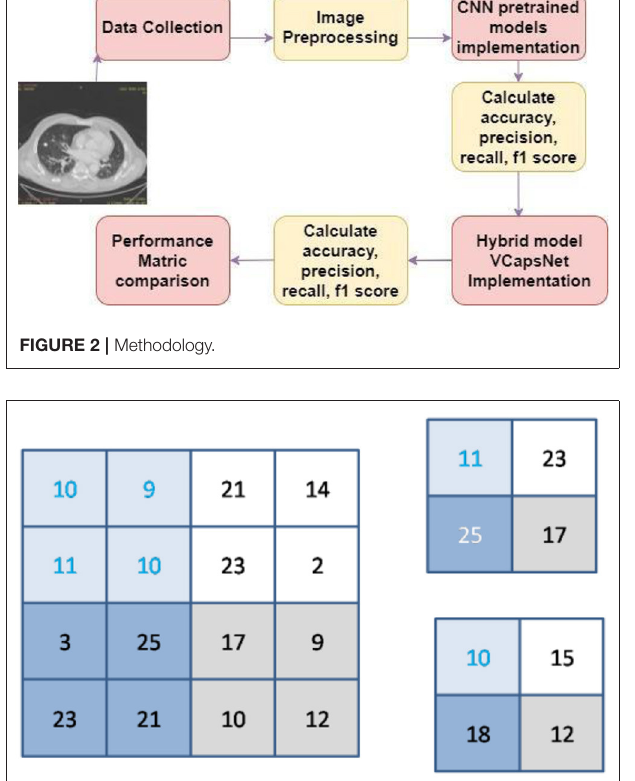
FIGURE 3 | Example of max & average pooling.